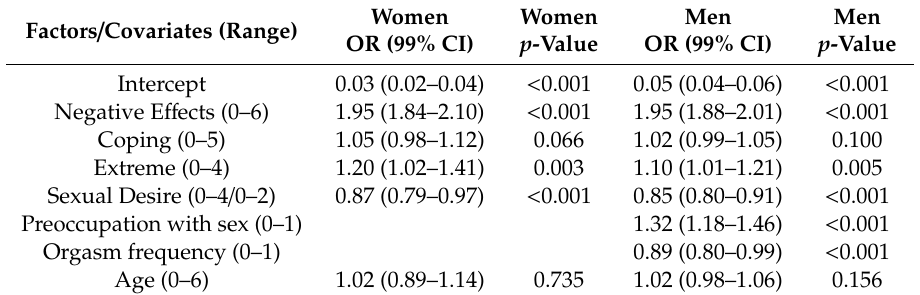
Table 3. Results of the logistic regression using “Experiencing the need for help” as criterion